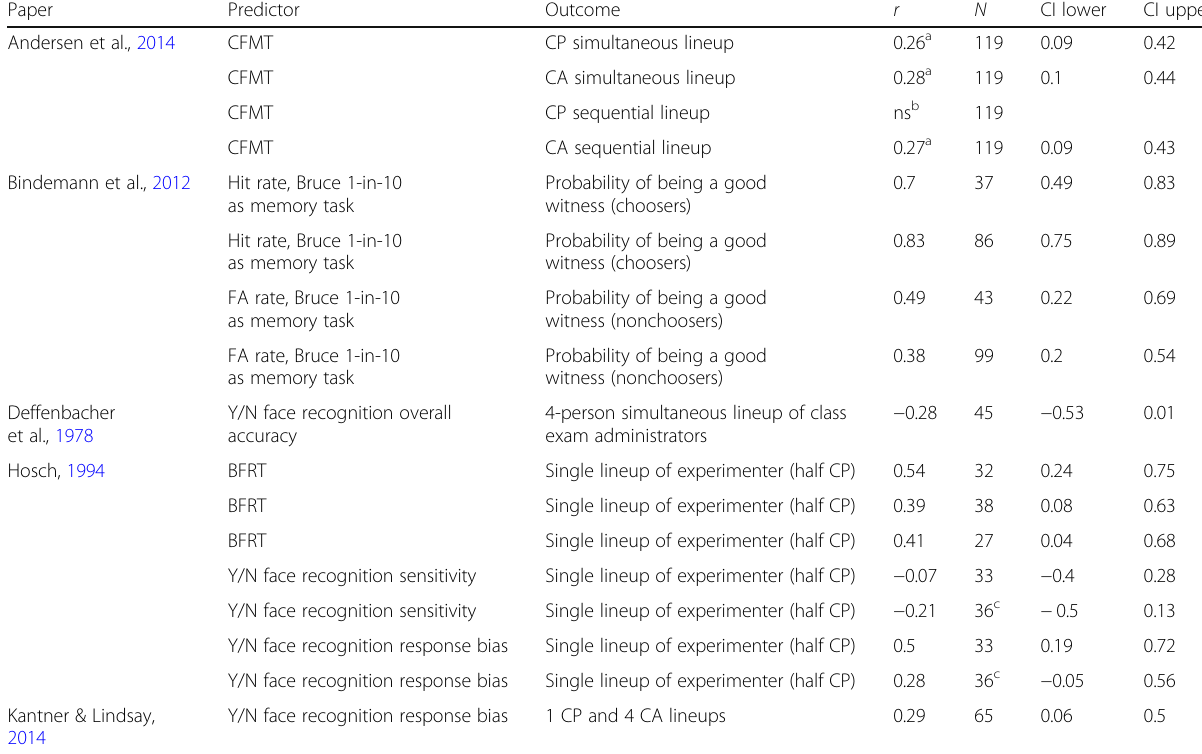
Table 2 Literature measuring correlation for lineup accuracy